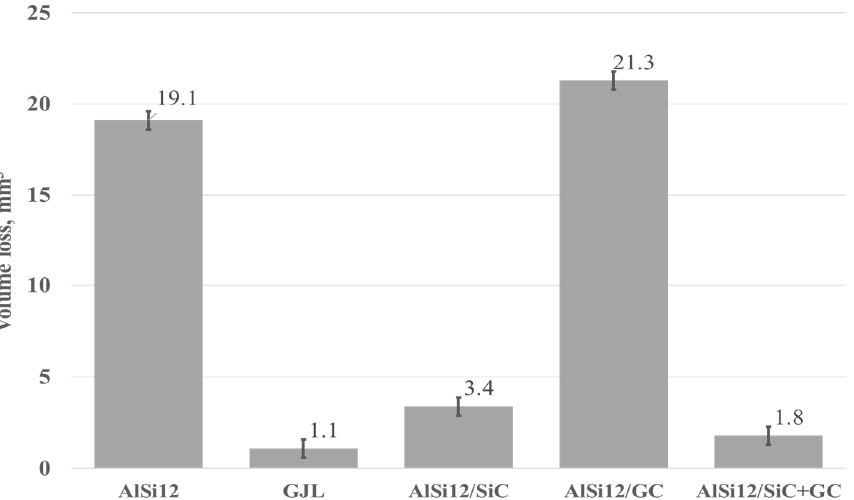
Figure 15. Volume loss of the tested materials calculated based on the wear track created under dry